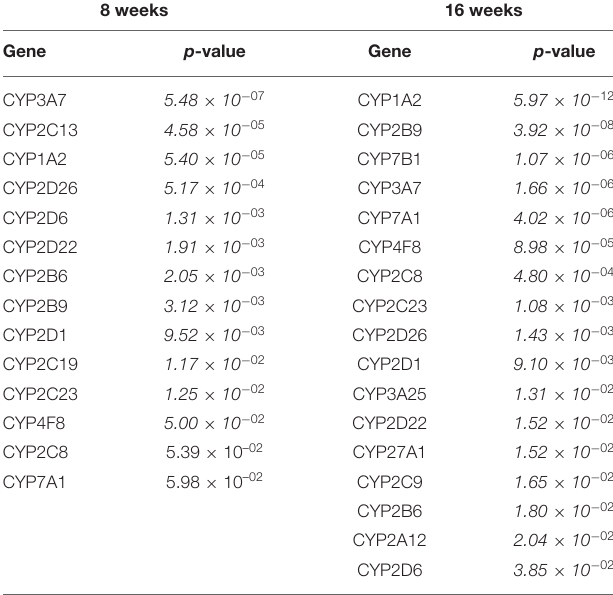
of regulator networks. Red molecules are upregulated, whereas green molecules are downregulated. Orange molecules are predicted to be activated and blue molecules are predicted to regulator. Uninterrupted arrows indicate the direct molecule– molecule interactions, while dashed arrows indicate that between those two molecules are intermediary molecules or steps.